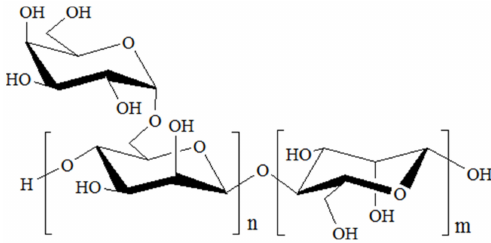
Figure 1. The typical structure of